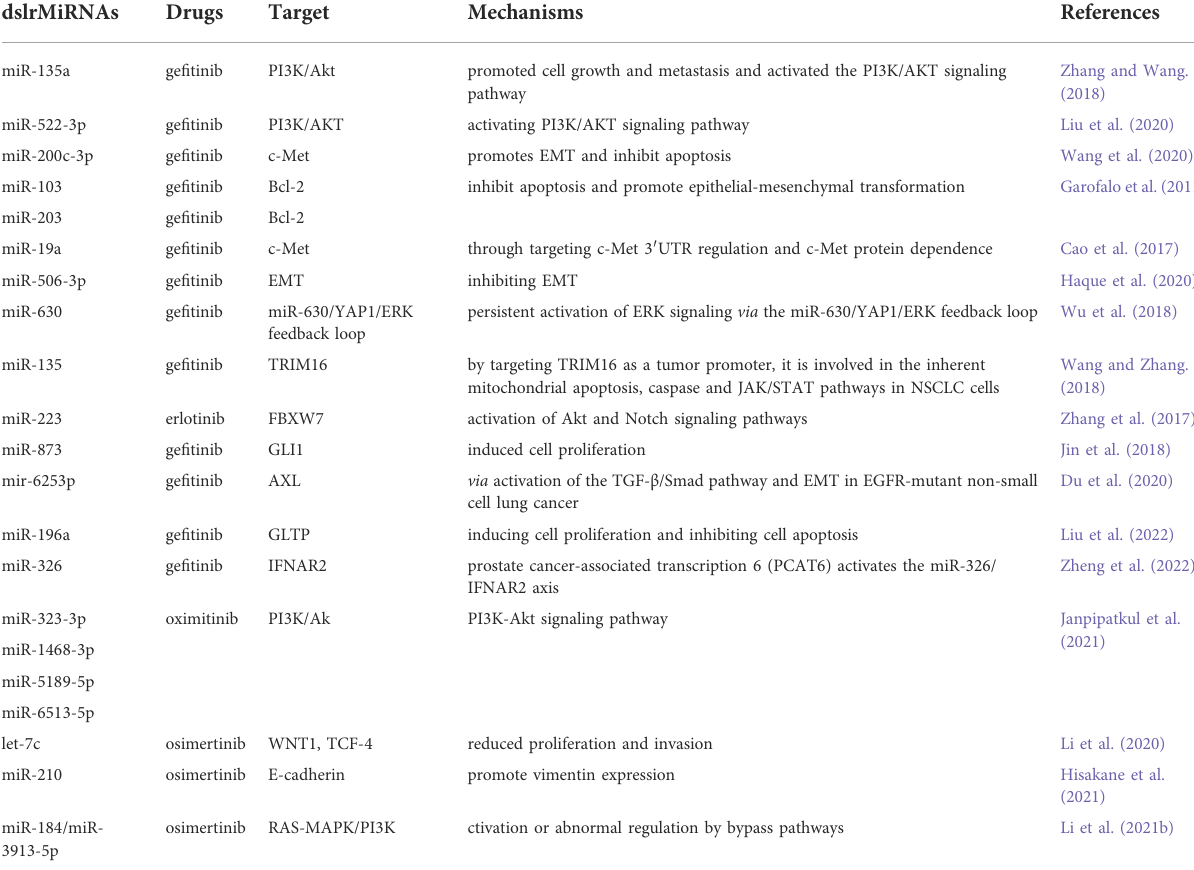
TABLE 2 Summary of miRNAs involved in drug resistance in targeted therapy of